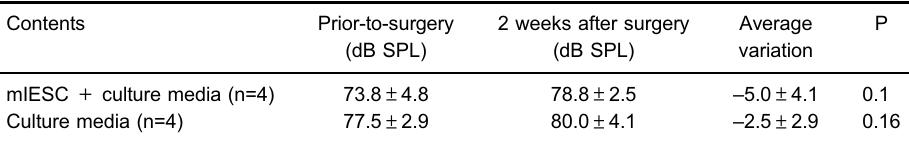
Table 2. Auditory threshold levels of the study group (mIESC + culture medium) and the control group (culture medium only) to pure tone (16 kHz) stimuli before surgery and at 2 weeks after